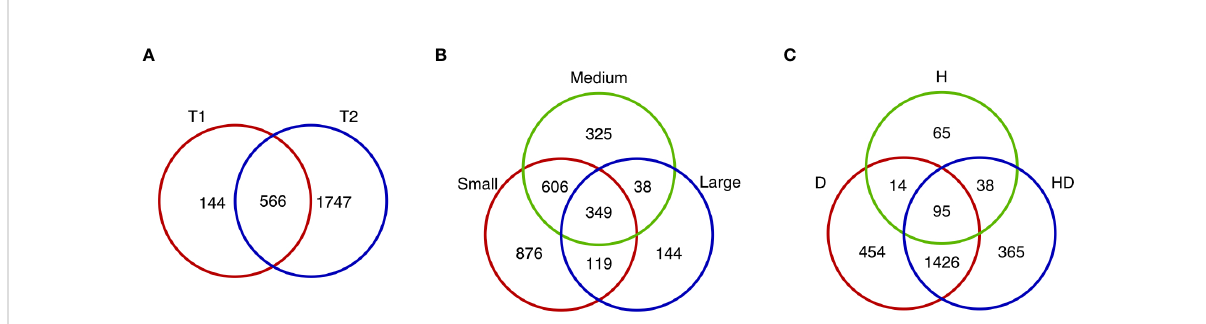
FIGURE 2 Venn diagrams visualizing the number of differentially expressed genes in fl ag leaves, speci fi c and shared between: (A) time points (T1 and T2), (B) barley genotypes assigned to groups of different sizes of fl ag leaf (small, medium, and large), and (C) applied stress treatments (D, H, and